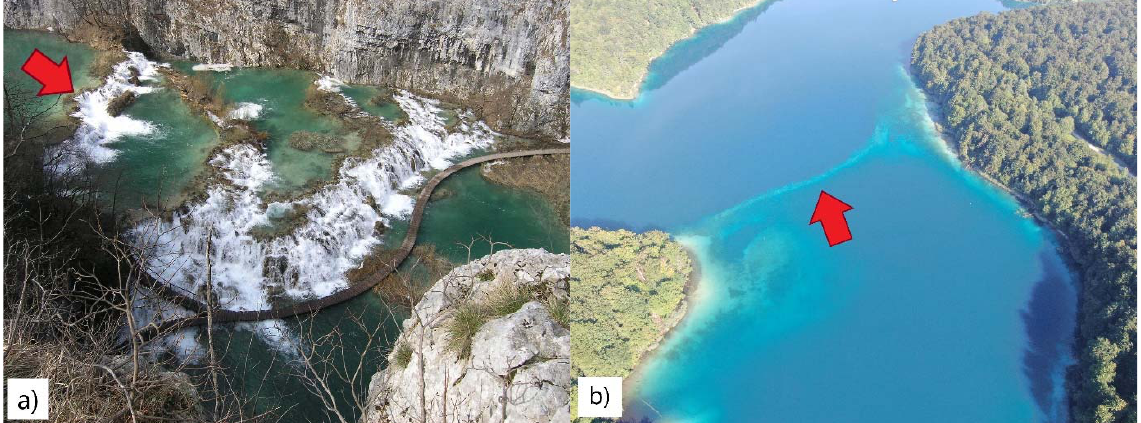
Figure 4. Tufa barriers (photo: Plitvi č ka Jezera National Park staff): ( a ) erosion of the central part of the tufa barrier with the concentrated water flow, ( b ) submerged barrier in Kozjak Lake.